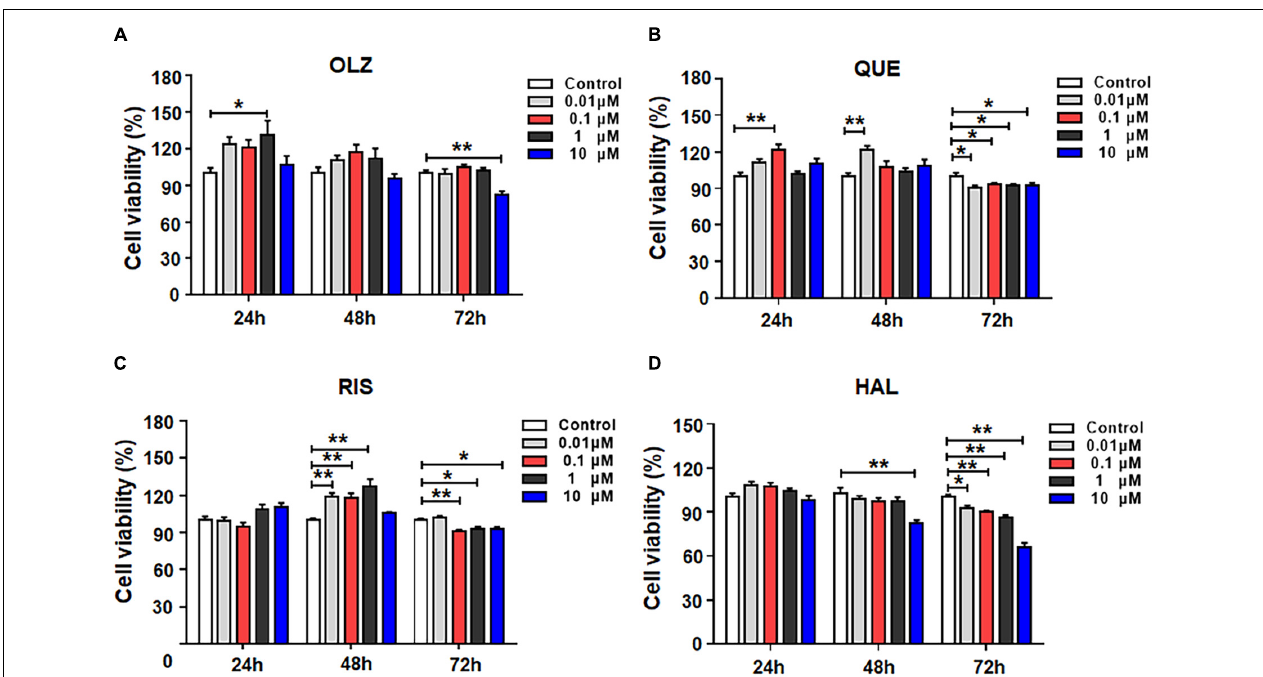
FIGURE 1 | The effects of 0.01, 0.1, 1, and 10 µ M olanzapine (A) , quetiapine (B) , risperidone (C) , and haloperidol (D) treatment for 24, 48, and 72 h on the viability of cultured astrocytes. The data are presented as the mean ± standard error of the mean. * p < 0.05, ** p < 0.01 vs. control (one-way analysis of variance and post hoc Dunnett’s multiple comparison test; n = 6–12 cultures/group). Con, control; OLZ, olanzapine; QUE, quetiapine; RIS, risperidone; HAL,